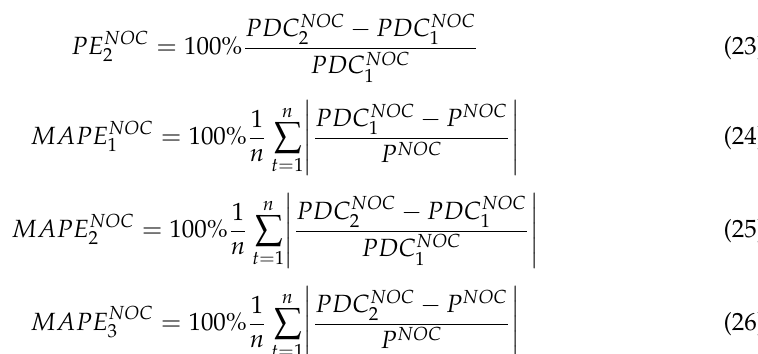
Figure 5. Histograms of the Percentage Error 𝑃𝐸 (cid:2869)(cid:3015)(cid:3016)(cid:3004) concerning 𝑃𝐷𝐶 (cid:2869)(cid:3015)(cid:3016)(cid:3004) and 𝑃 (cid:3015)(cid:3016)(cid:3004) ( a ), and the Percentage Error 𝑃𝐸 (cid:2870)(cid:3015)(cid:3016)(cid:3004) concerning 𝑃𝐷𝐶 (cid:2870)(cid:3015)(cid:3016)(cid:3004) and 𝑃𝐷𝐶 (cid:2869)(cid:3015)(cid:3016)(cid:3004) ( b ); polycrystalline modules.